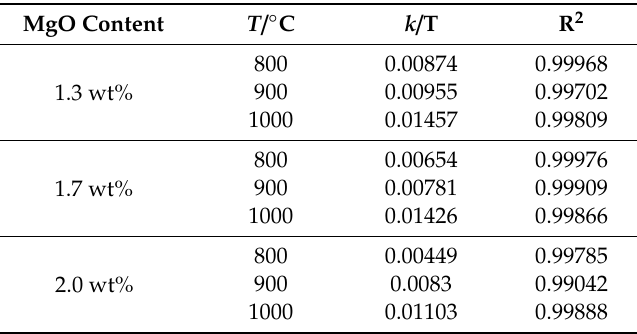
Table 5. Rate constant and degree of fitting.